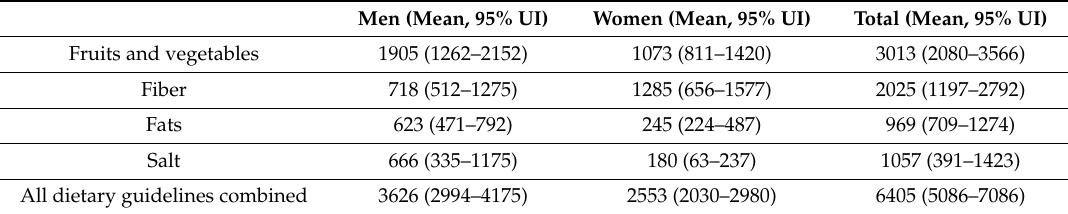
Table 2. Estimated number of total deaths averted or delayed by specific dietary changes according to guidelines in a year in Sweden.